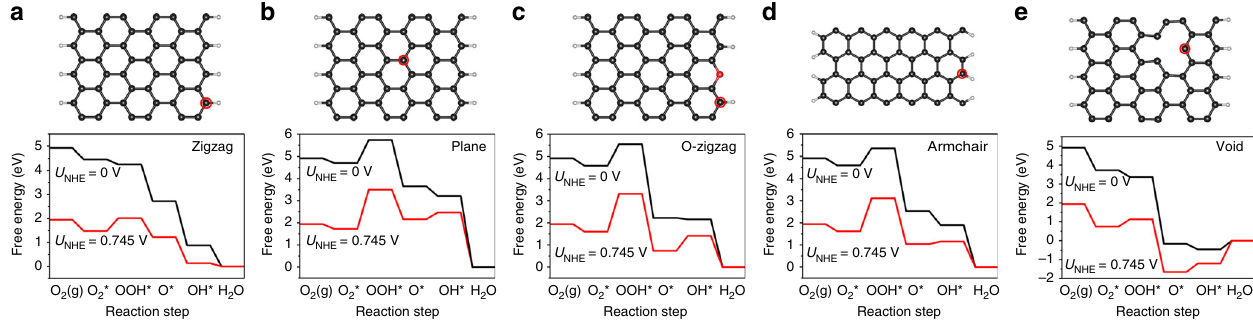
Fig. 5 Theoretical calculations. Models (top) and the corresponding free energy diagrams (bottom) for cycled carbon atoms at electrode potential U NHE = 0 and 0.745 V in 0.5 M H 2 SO 4 (NHE normal hydrogen electrode, RHE reversible hydrogen electrode, U NHE = U RHE − 0.0591 × pH, pH = 0.25). a Carbon atom at zigzag edge, b carbon atom in basal plane, c carbon atom at O-doped zigzag edge, d carbon atom at armchair edge, and e carbon atom near a